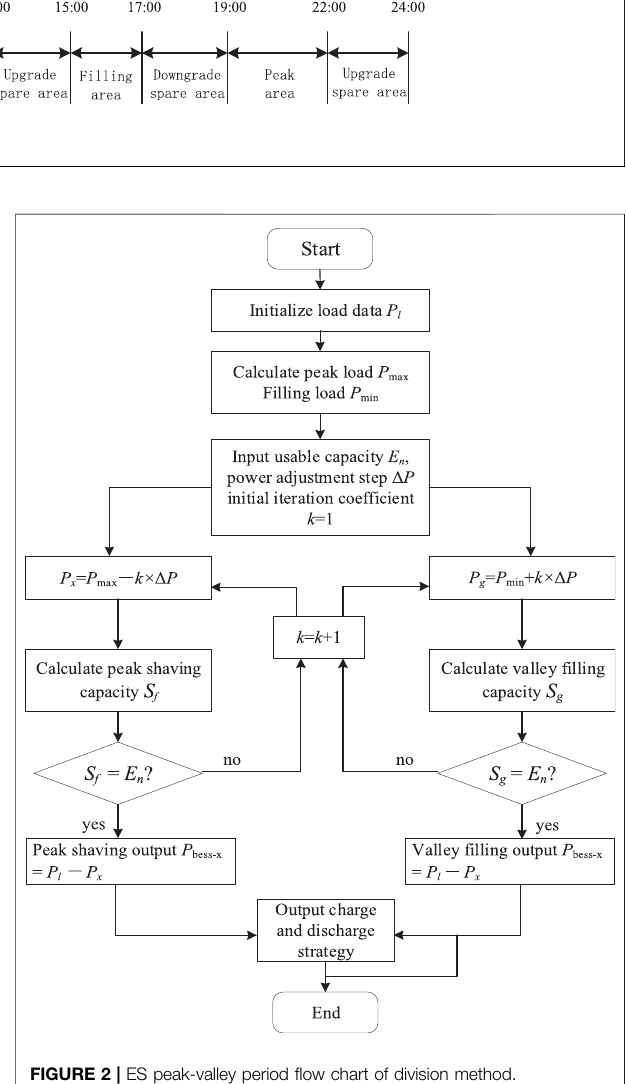
FIGURE 2 | ES peak-valley period fl ow chart of division